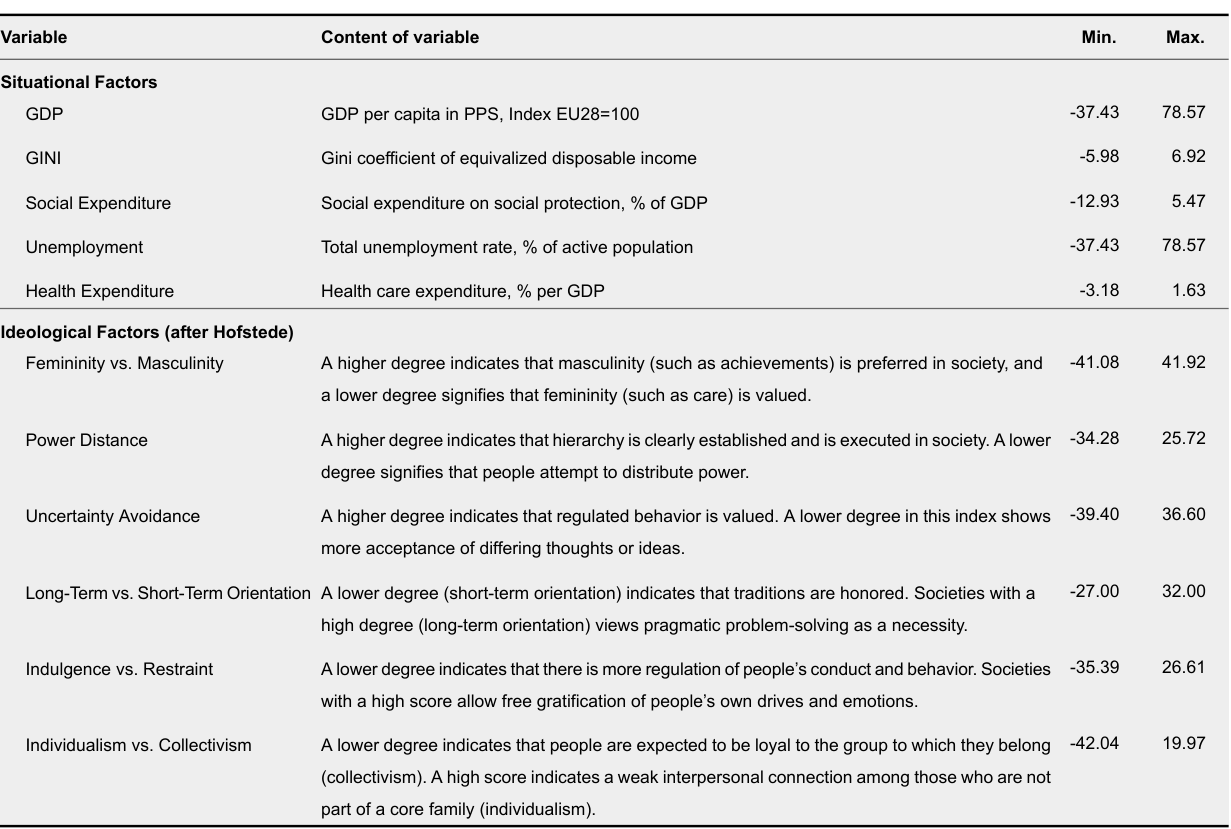
Country Level Situational and Ideological Factors in 20 Countries (Grand Mean